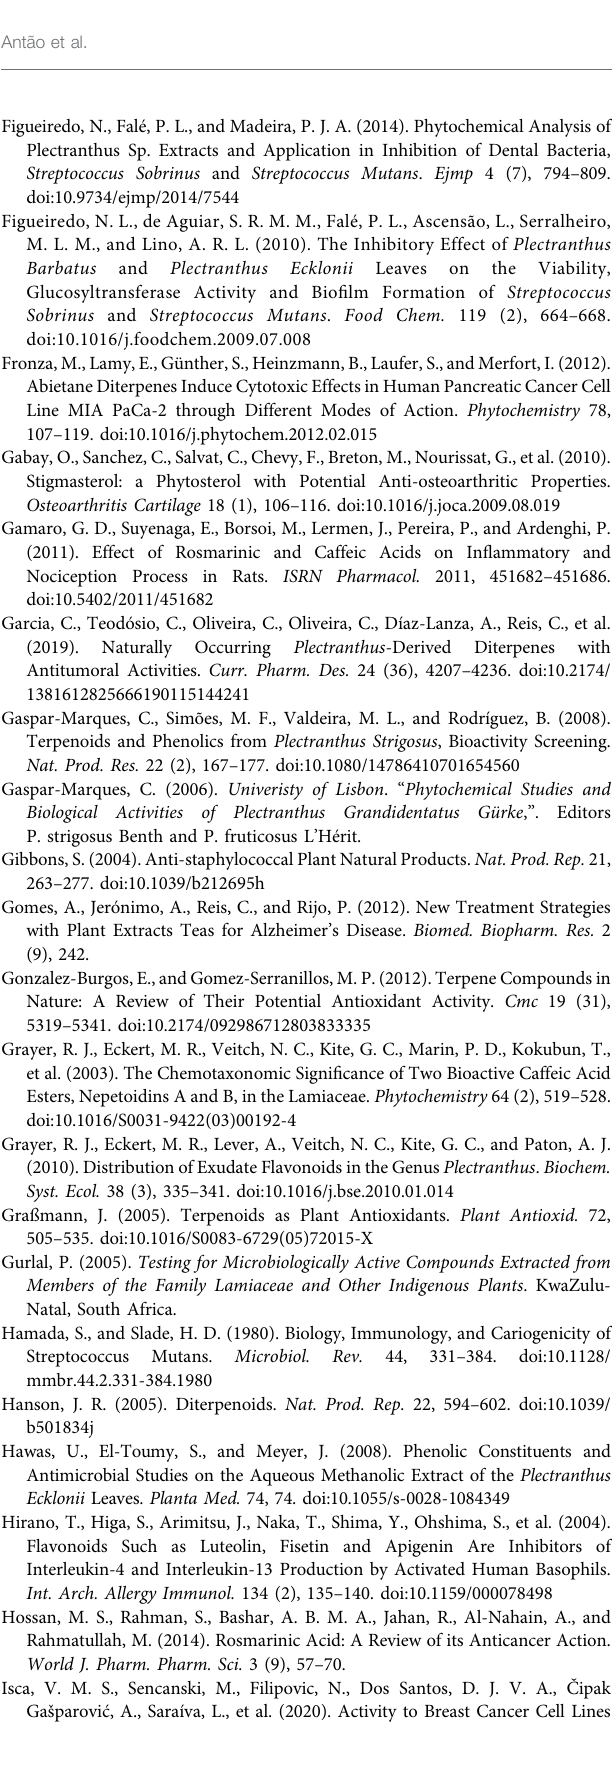
Figueiredo, N., Falé, P. L., and Madeira, P. J. A. (2014). Phytochemical Analysis of Plectranthus Sp. Extracts and Application in Inhibition of Dental Bacteria,